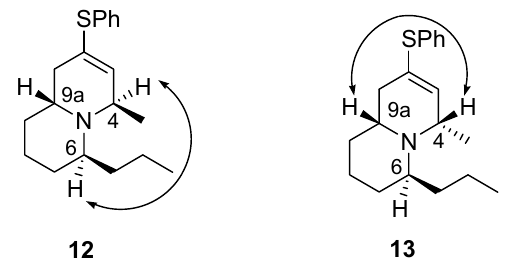
Scheme 3. Preparation of compounds 15 and 16